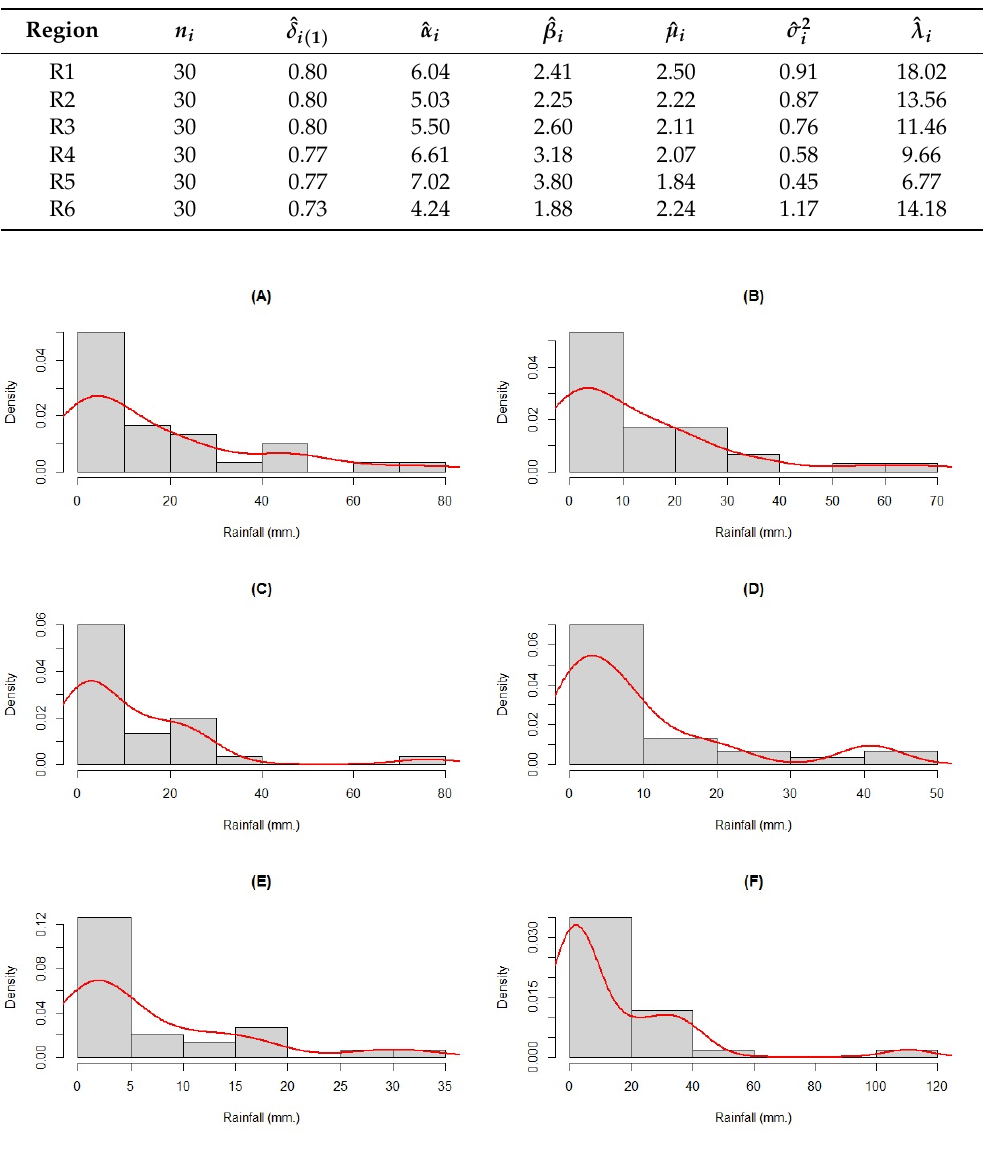
Figure 6. The densities of the rainfall datasets for the six regions in Thailand: ( A ) Northern ( B ) South- ern ( C ) Northeastern ( D ) Eastern ( E ) Western ( F )